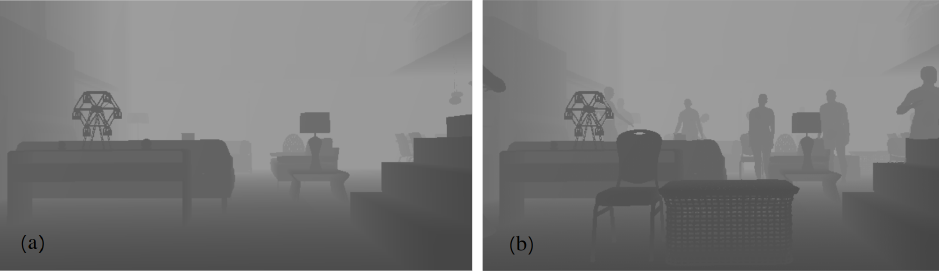
Figure 14. Depth buffer on the left ( a ) and augmented depth buffer on the right ( b